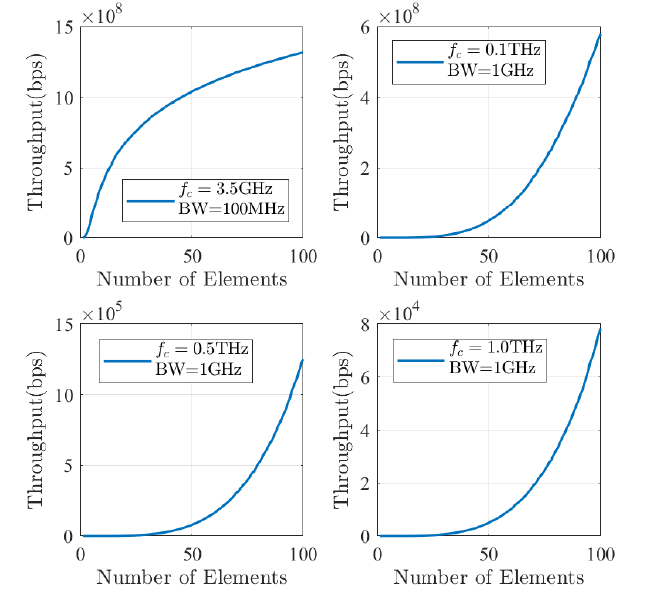
Figure 5. The throughput comparison.